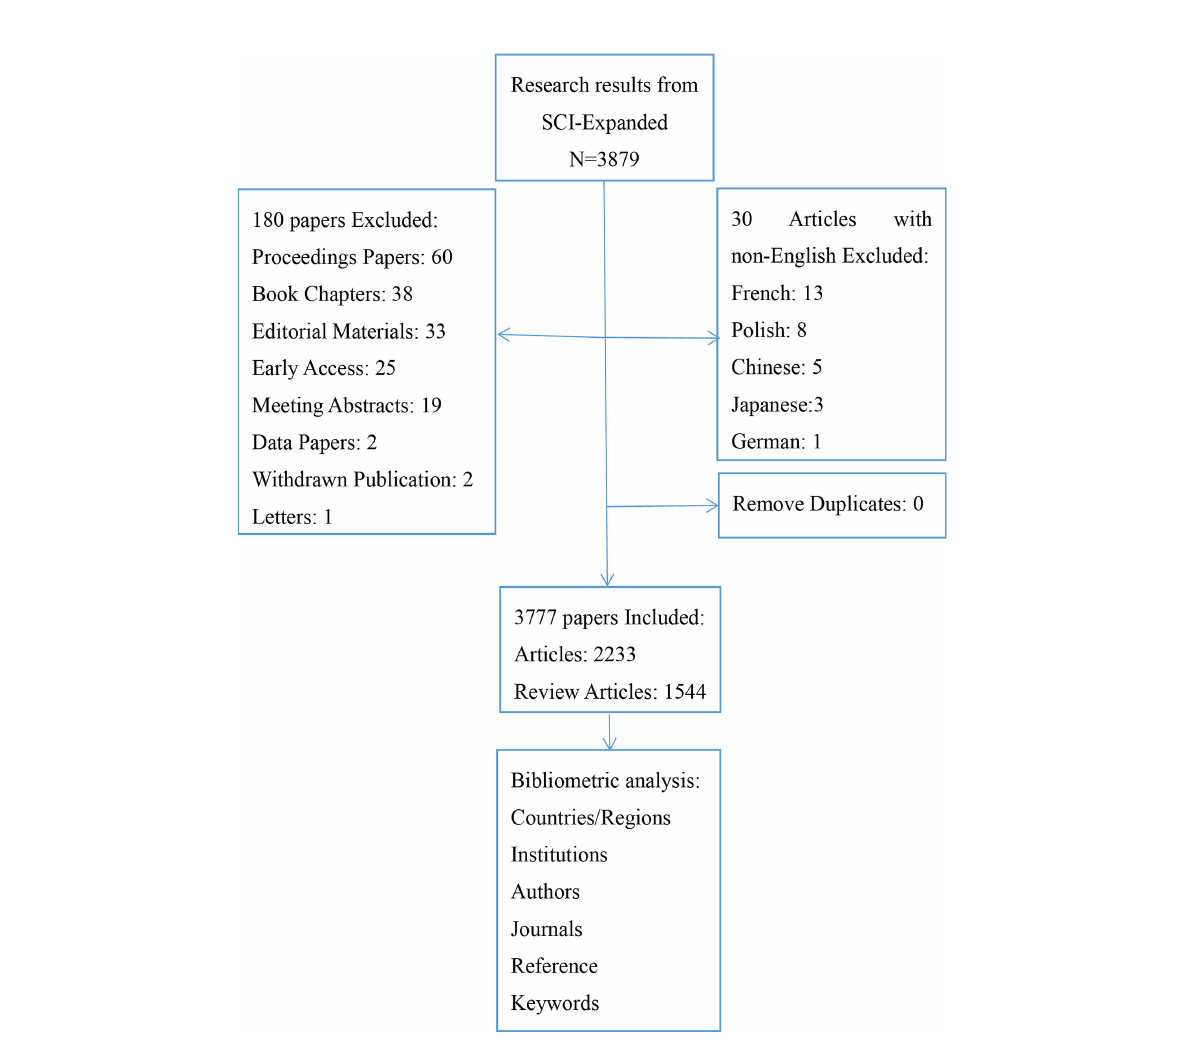
FIGURE 1 Flow chart of literature inclusion and exclusion. Source: authors with